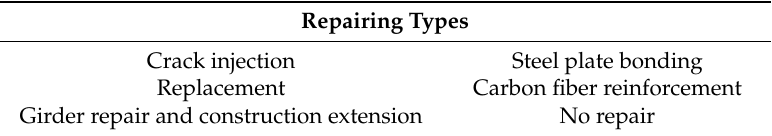
Table 4. Repair types in Tokyo region.